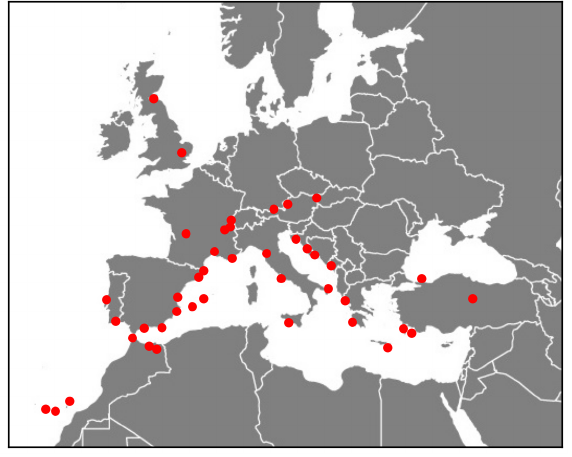
Figure 1. Map of origin/destination airports for Rotterdam Airport during the period January 2017–February 2020.